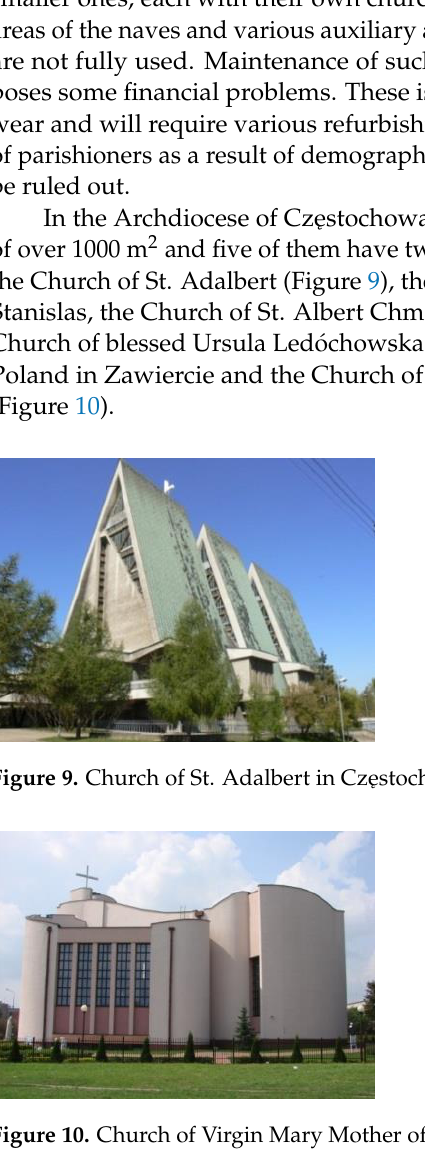
Figure 10. Church of Virgin Mary Mother of the Church in Radomsko (built in 1981–1991).